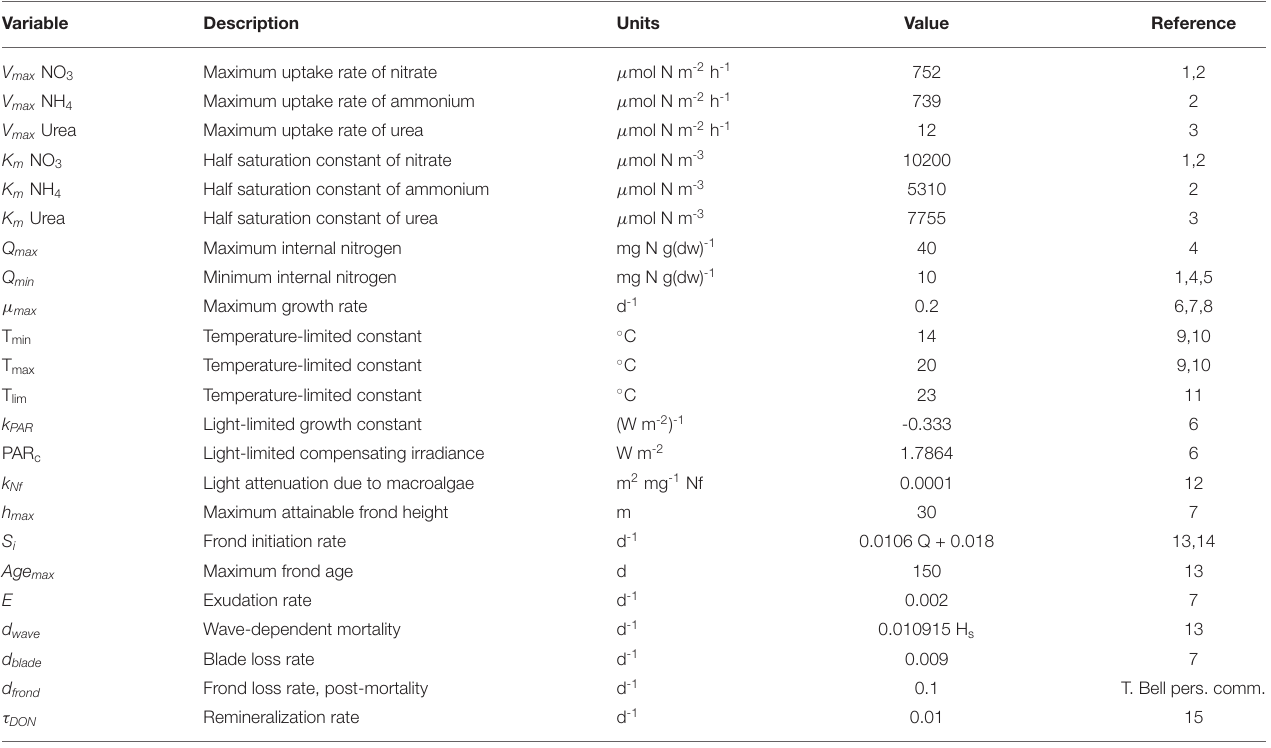
TABLE 1 | Biological parameters for the macroalgal growth